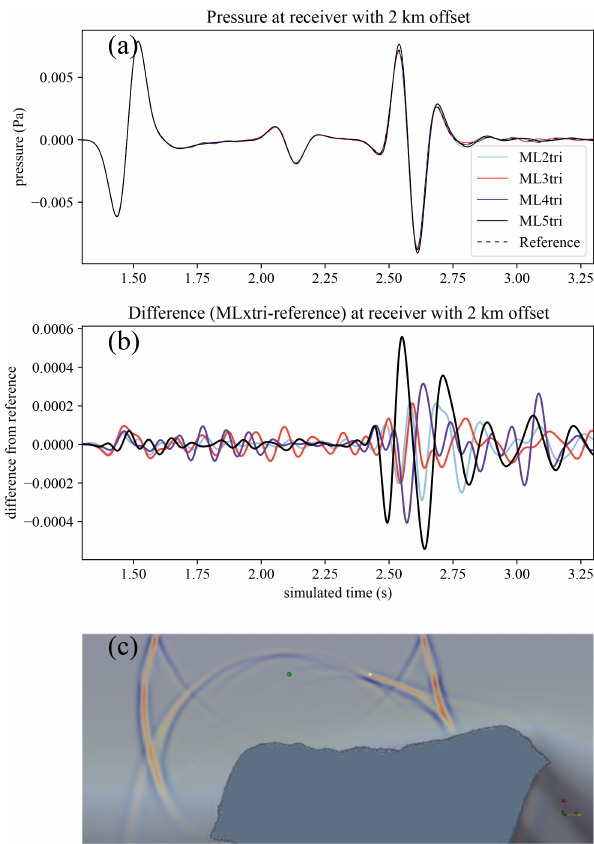
Figure 11. Panel (a) shows time series of pressure for several el- ements measured at a receiver with an offset of 2 . 00km. The dif- ference (MLxtri − reference) in signals from the reference case is shown in panel (b) , where x varies from 2 to 5. Panel (c) is the wave field at t = 2 . 53s with the receiver at 2 . 00km emphasized with a triangular glyph. The difference in the signals is greatest when the wave reflected by the salt body (indicated by darker blue in panel c ) passes through the receiver also illustrated in panel (c)